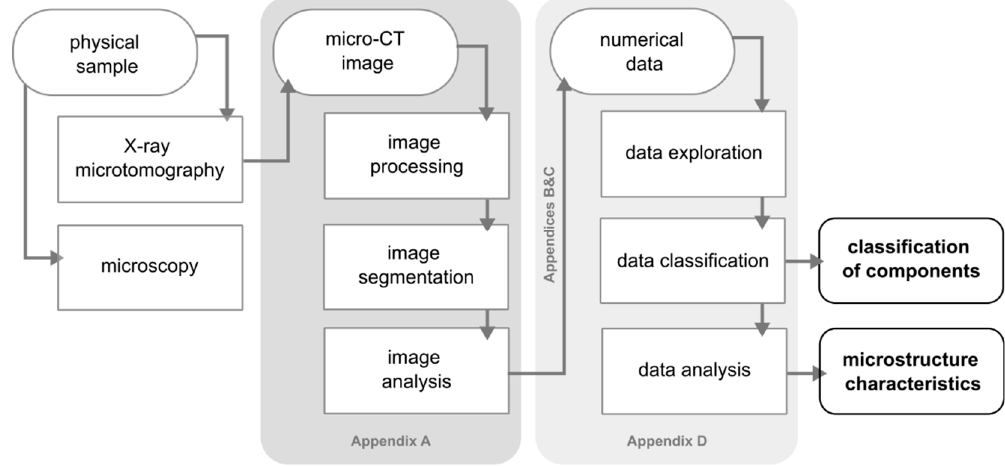
Figure 2. The workflow of data processing and analysis.